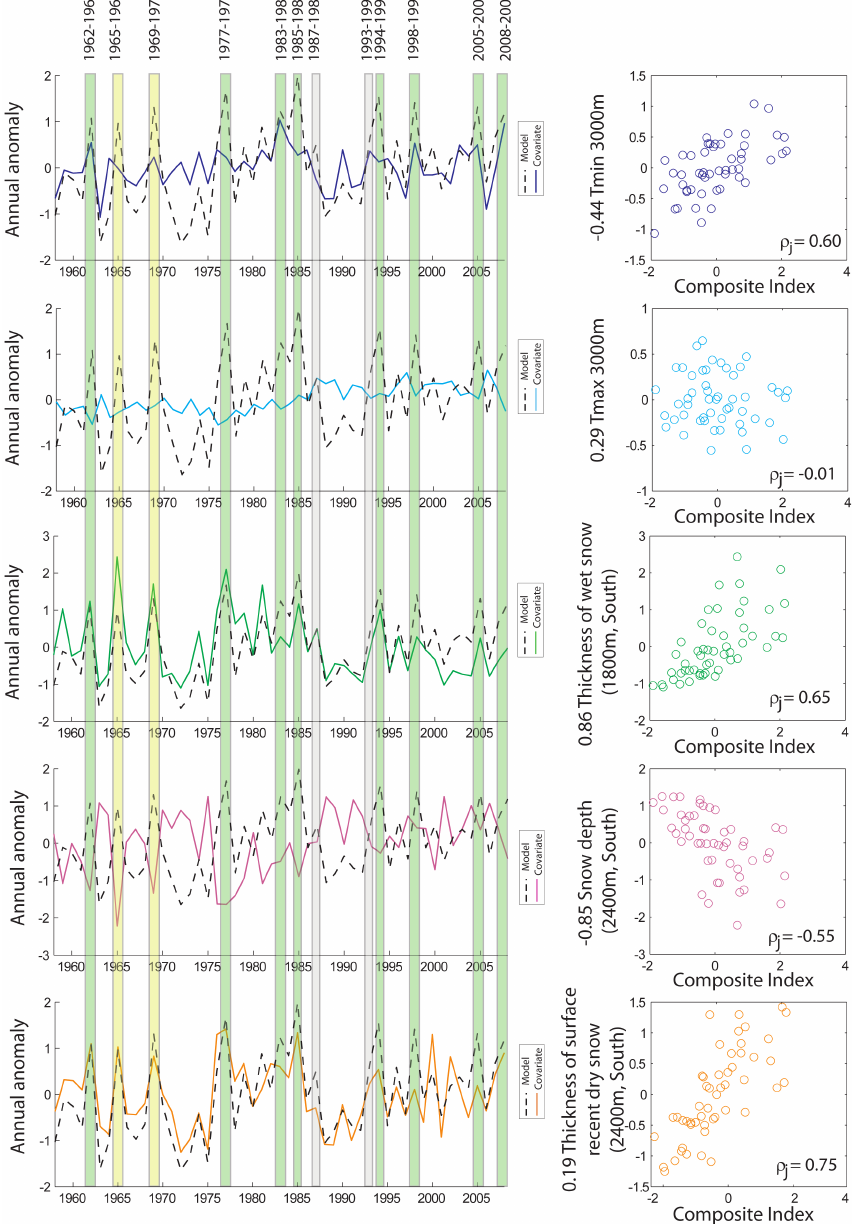
Fig. 5. Temporal evolution of the covariates retained in the regression model of the composite index, for the whole French Alps, and scatter .β j and the CI. ρ j is the corresponding correlation coefficient. Green bands correspond to plots between each weighted covariate X norm jt years for which the CI and its regression model exceed the 80th percentile threshold (see Table 2). Yellow and grey bands correspond to years for which only the model or the CI exceeds the threshold,